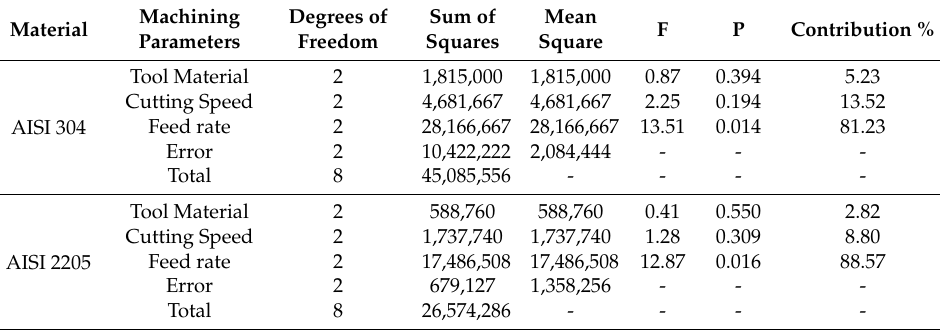
Table 10. Results of analysis of variance (ANOVA) for specific cutting